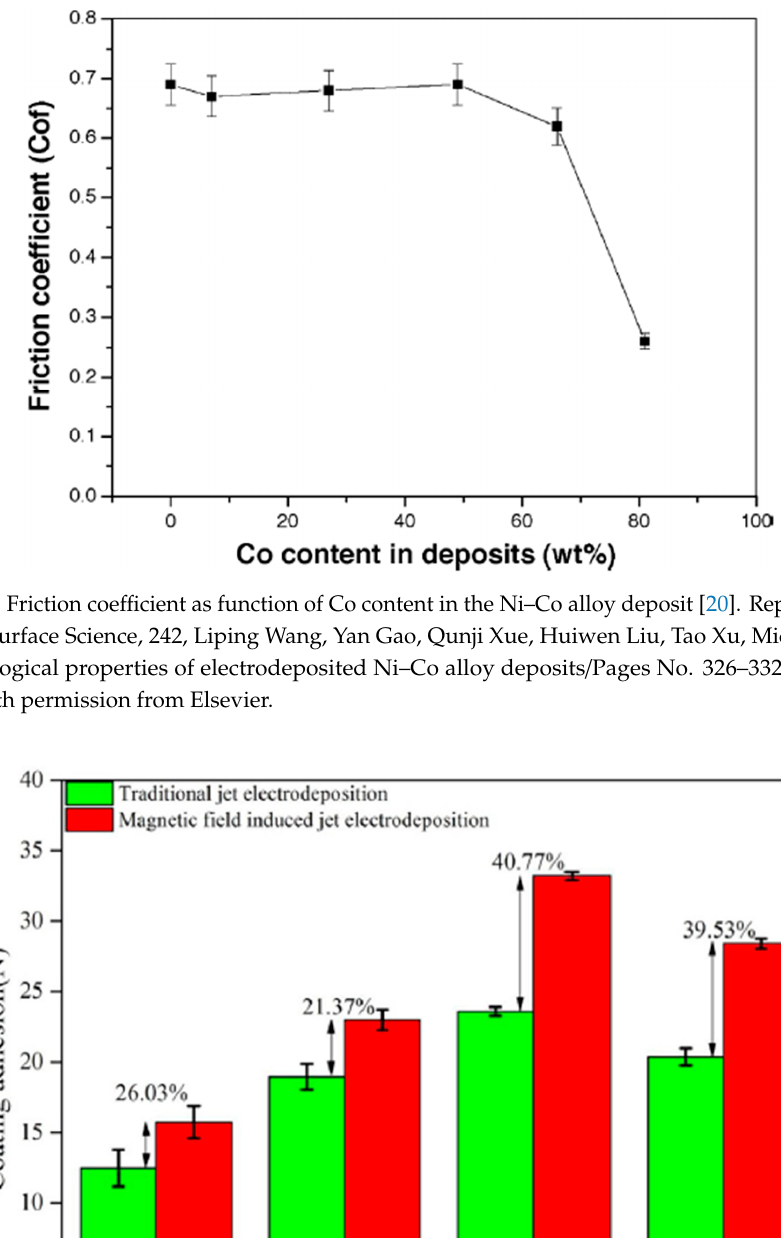
Figure 12. Materials 2020 , 13 , x FOR PEER REVIEW